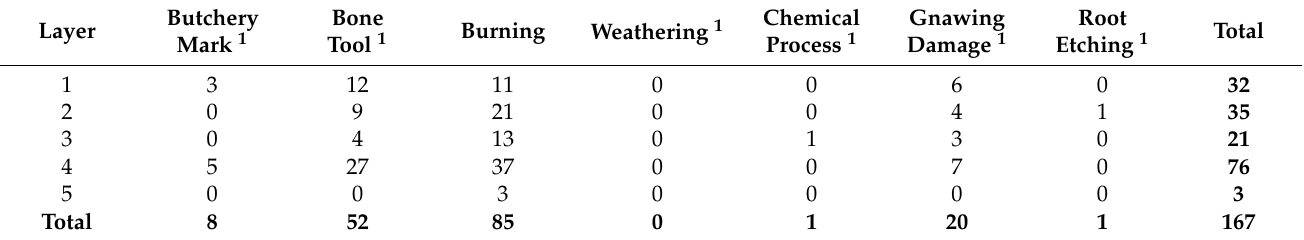
Table 4. Taphonomic evidence in Area 2 of the Ban Rai Rockshelter, in numbers of specimens.